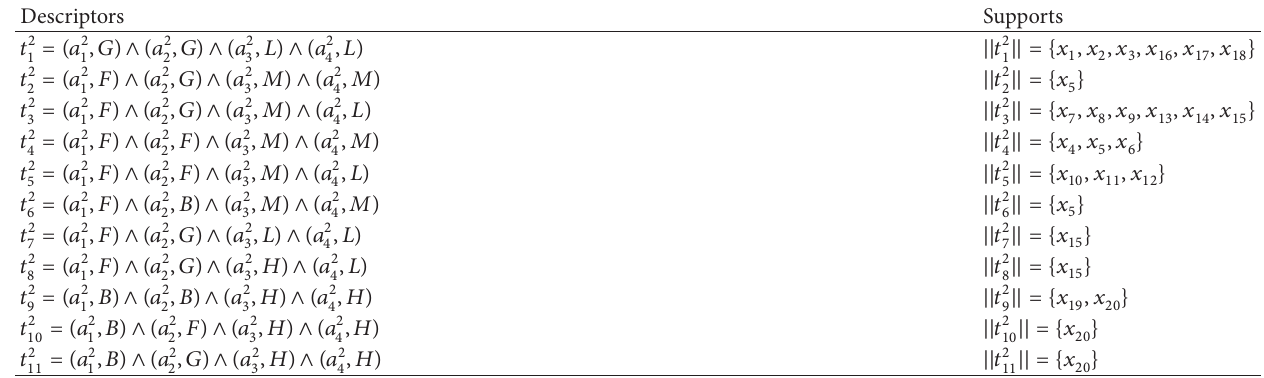
Table 3: Full AT 2 descriptors and their supports.